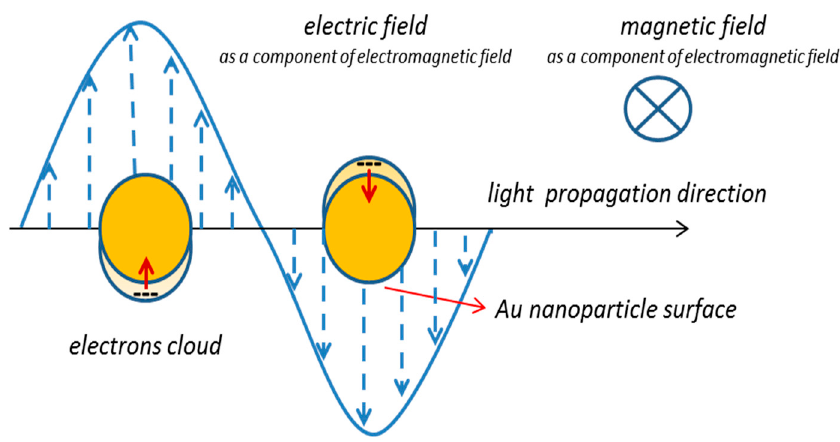
Figure 14. Schematic illustration of the localized surface plasmon resonance for spherical Au nanoparticles. Red arrows mean an induced dipole moment, which is the result of displacement electrons cloud (marked by “---“). The dashed arrows mean electric field lines, and the orange circle represents an Au nanoparticle.